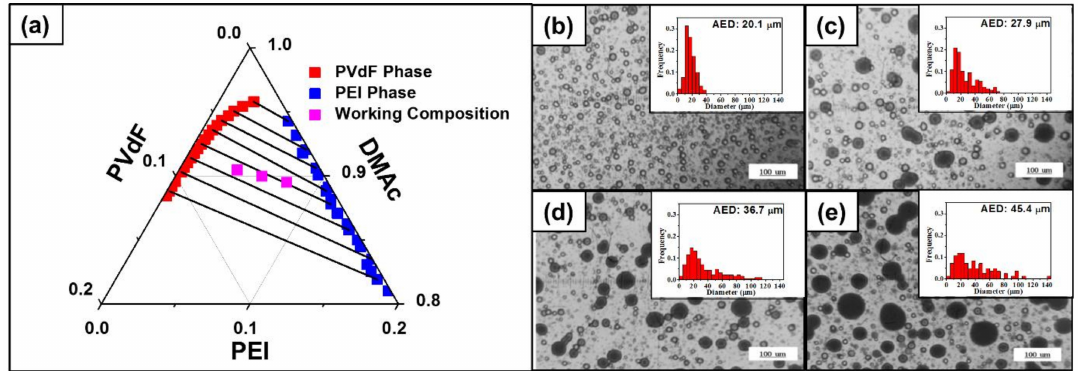
Figure 1. ( a ) Computed bimodal curve and tie lines of two polymers, PEI and PVdF, in DMAc solvent and optical microscope (OM) images and PEI droplet size distribution of PEI/PVdF (1:1 wt. ratio) blend solution after a waiting time of ( b ) 10 min; ( c ) 20 min; ( d ) 30 min; and ( e ) 40 min without stirring. The frequencies in insets were normalized by the number of counted samples. AED is the abbreviation for average emulsion